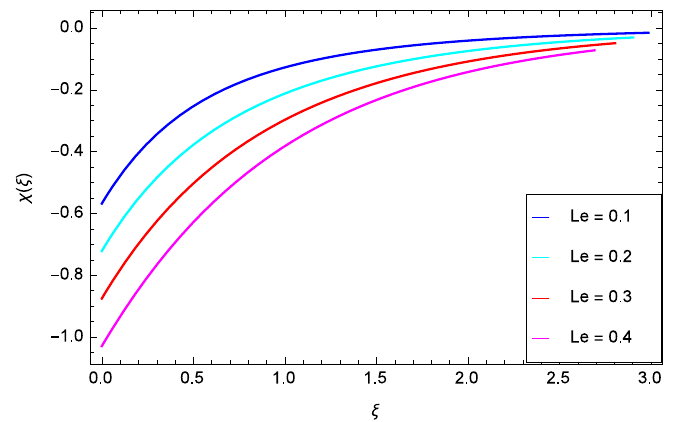
Figure 21. Impact of the Lewis number Le on motile microorganism χ ( ζ ) .